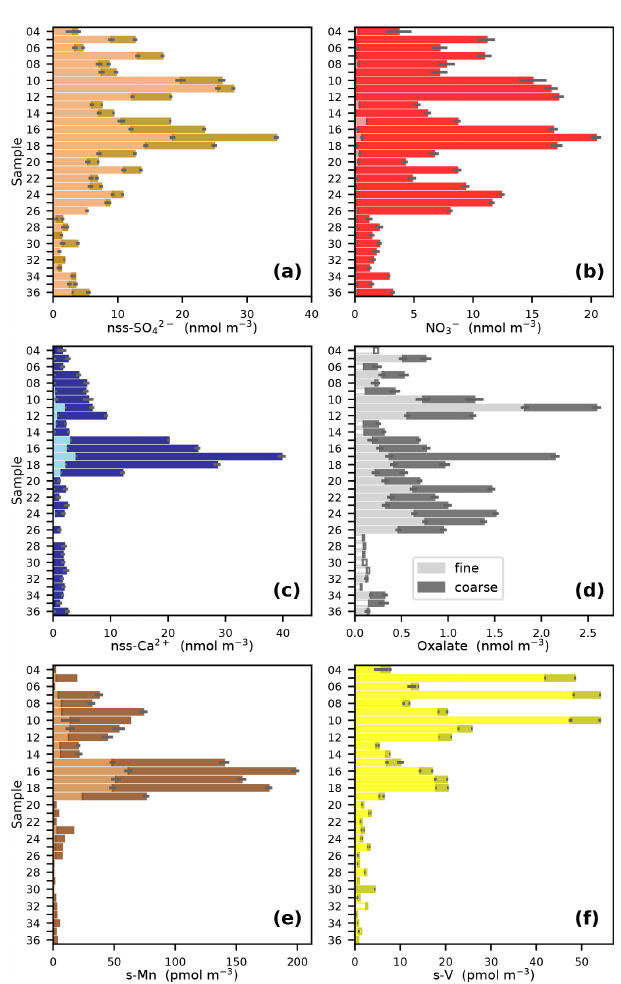
Figure 2. Fine ( < 1µm) and coarse ( > 1µm) aerosol concentra- tions of (a) NO − , (b) nss-SO 2 − , (c) nss-Ca 2 + , (d) oxalate, (e) s- 3 4 Mn and (f) s-V during the AMT21 cruise. For samples 15 and 30, the fine and coarse fractions are the sum of impactor stages 5 and 6 and the backup filter and impactor stages 1–4, respectively. Where concentrations were below detection limit, these are indicated by unfilled bars whose magnitude corresponds to 75% of the detection